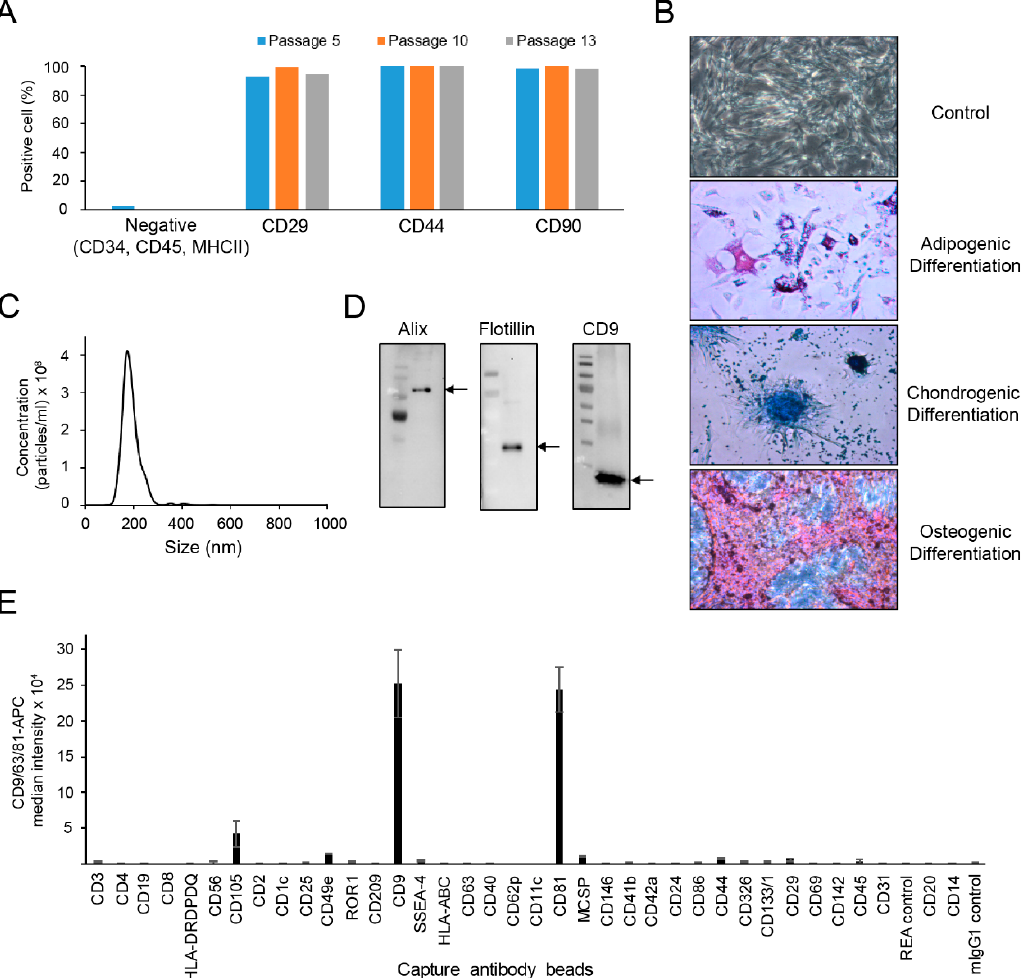
Figure 1. Characterization of canine adipose tissue-derived mesenchymal stem cells (cASC) and cASC-EV. ( A ) Bar graph obtained from flow cytometry data show the expression of MSC-positive markers such as CD29, CD44 and CD90 in cASCs populations. ( B ) Representative data showing the differentiation phenotypes of cASC. ( C ) Representative histogram of particle concentration and size distribution of cASC-EV measured by nanoparticle tracking analysis (NTA). ( D ) The presence of EV markers such as Alix, Flotilin and CD9 in cASC-EV as determined by Western blots. ( E ) Surface signature of cASC-EV quantified by MACSPlex EV kit in conjunction with flow cytometry. Data indicate APC median signal intensities of ASC-EV incubated with the 39 capture beads and stained with a mixture of CD9-, CD63-, and CD81-APC antibodies. Background was corrected by subtraction of median fluorescence APC intensity.